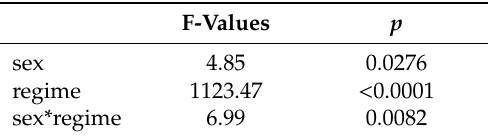
Table 2. Analysis of variance (general linear model) applied to the logarithm of antibody titre on whole set. The shift to the logarithm allowed for smoothing the outlier values, with subsequent normal distribution. Of note is the statistical significance of the sex*regime interaction term, whose F-value of 6.99 is greater than 4.85 for the sex e ff ect (see text results).